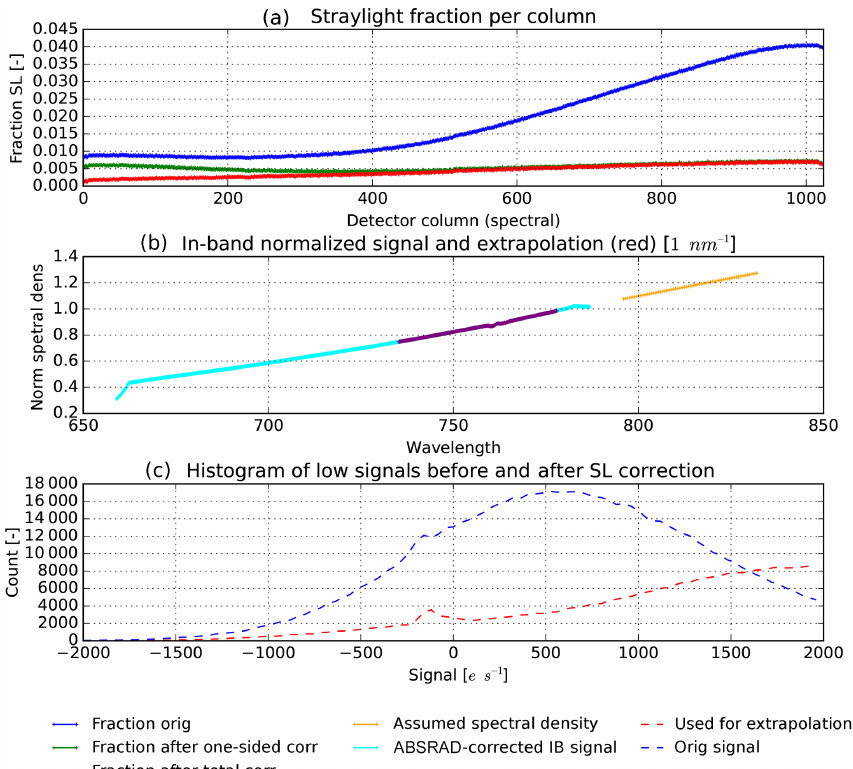
Figure 29. (a) The total straylight fraction per NIR detector column, before (blue line) and after out-of-band straylight correction for the red side (green line) and both sides (red line). (b) The spectral extrapolation as based on the in-band signal (shown in turquoise). The in- band signal is corrected for absolute radiance and normalized to a characteristic in-band wavelength. The thin blue line denotes the region (roughly between 730 and 780nm) on which the extrapolation is based. The extrapolation is linear in this case and shown as an orange line. (c) Histogram of the low signals below 2000e − s − 1 , before (blue dashes) and after (red dashes) out-of-band straylight correction.